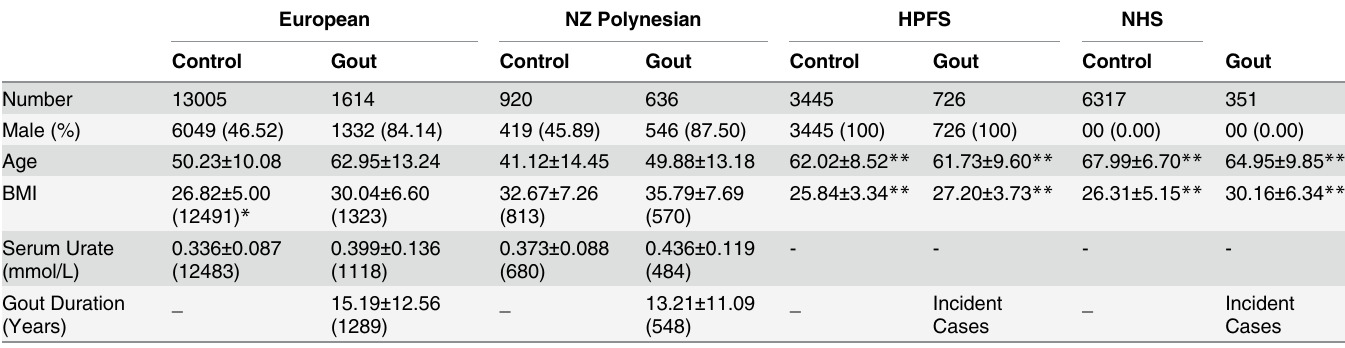
Table 1. Demographic and clinical data of